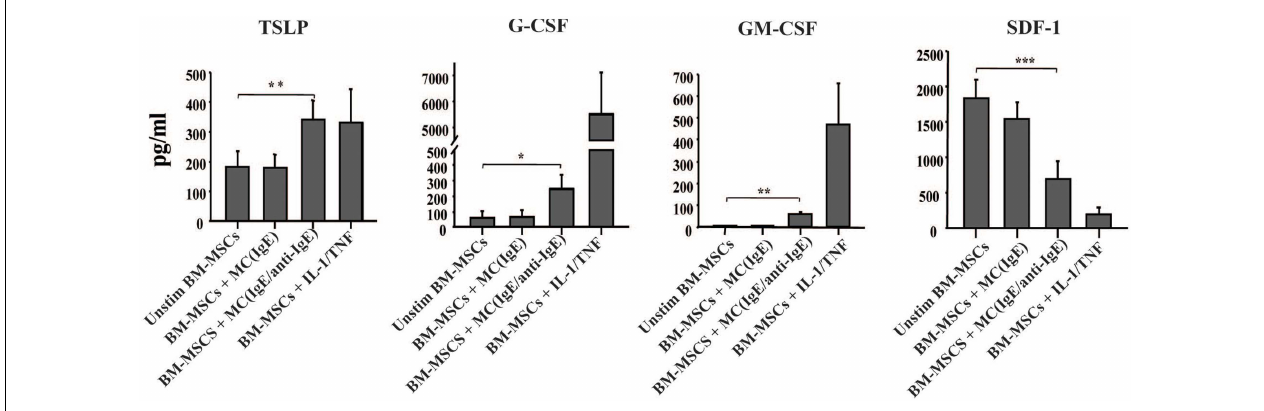
stromal cells were left for additional 42h and their supernatants were analyzed for the production of cytokines (pg/ml). Supernatants of BM-MSCs stimulated with IL-1/TNF (10 and 25ng/ml, respectively) for 48h were used as a positive control. Mean ± SEM of six to ten